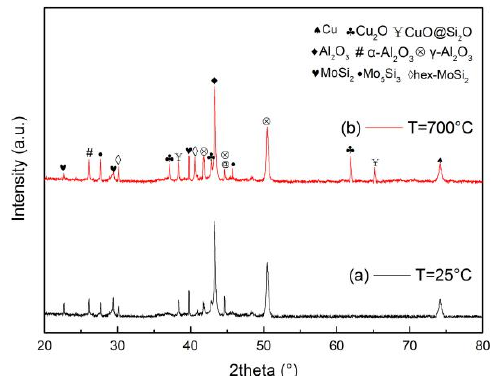
Figure 5. X-ray diffraction of the Al 2 O 3 –MoSi 2 /Cu composite coating surface: ( a ) T = 25 °C ( b ) T = 700 °C.